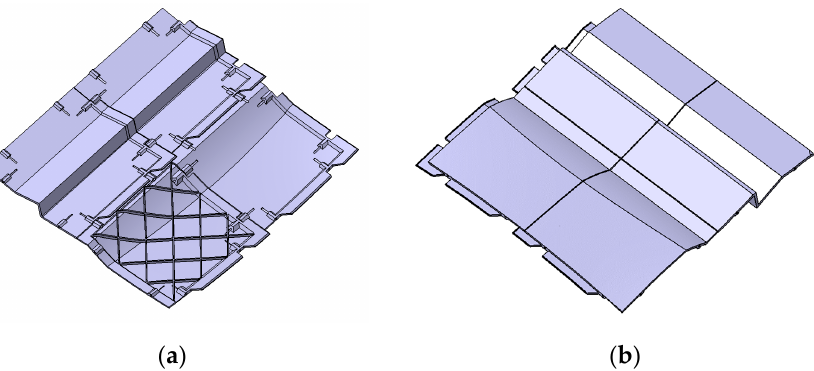
Figure 16. Final assembly after application of the method with the integration of lightweight opti- mization on the bottom segment in form of a diamond-grid rib structure. ( a ) Backside of the assembly; ( b ) Topside of the assembly.